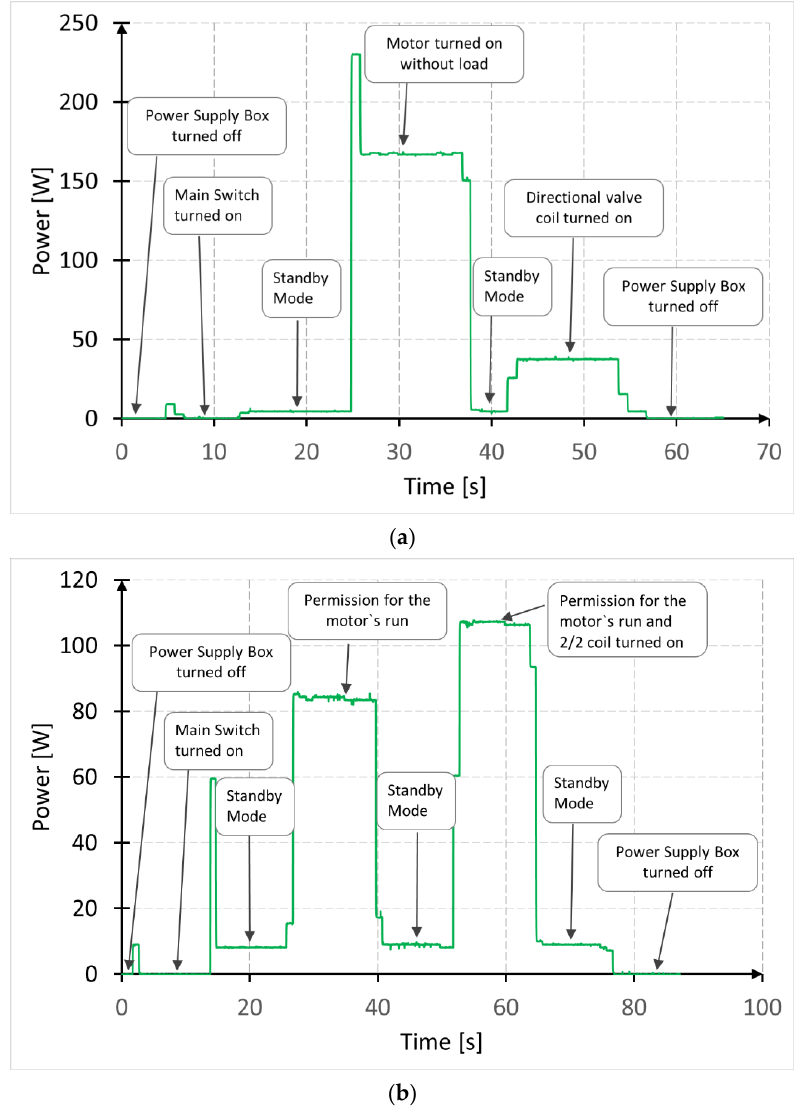
Figure 4. Power demand: ( a ) conventional drive, ( b ) EHD.